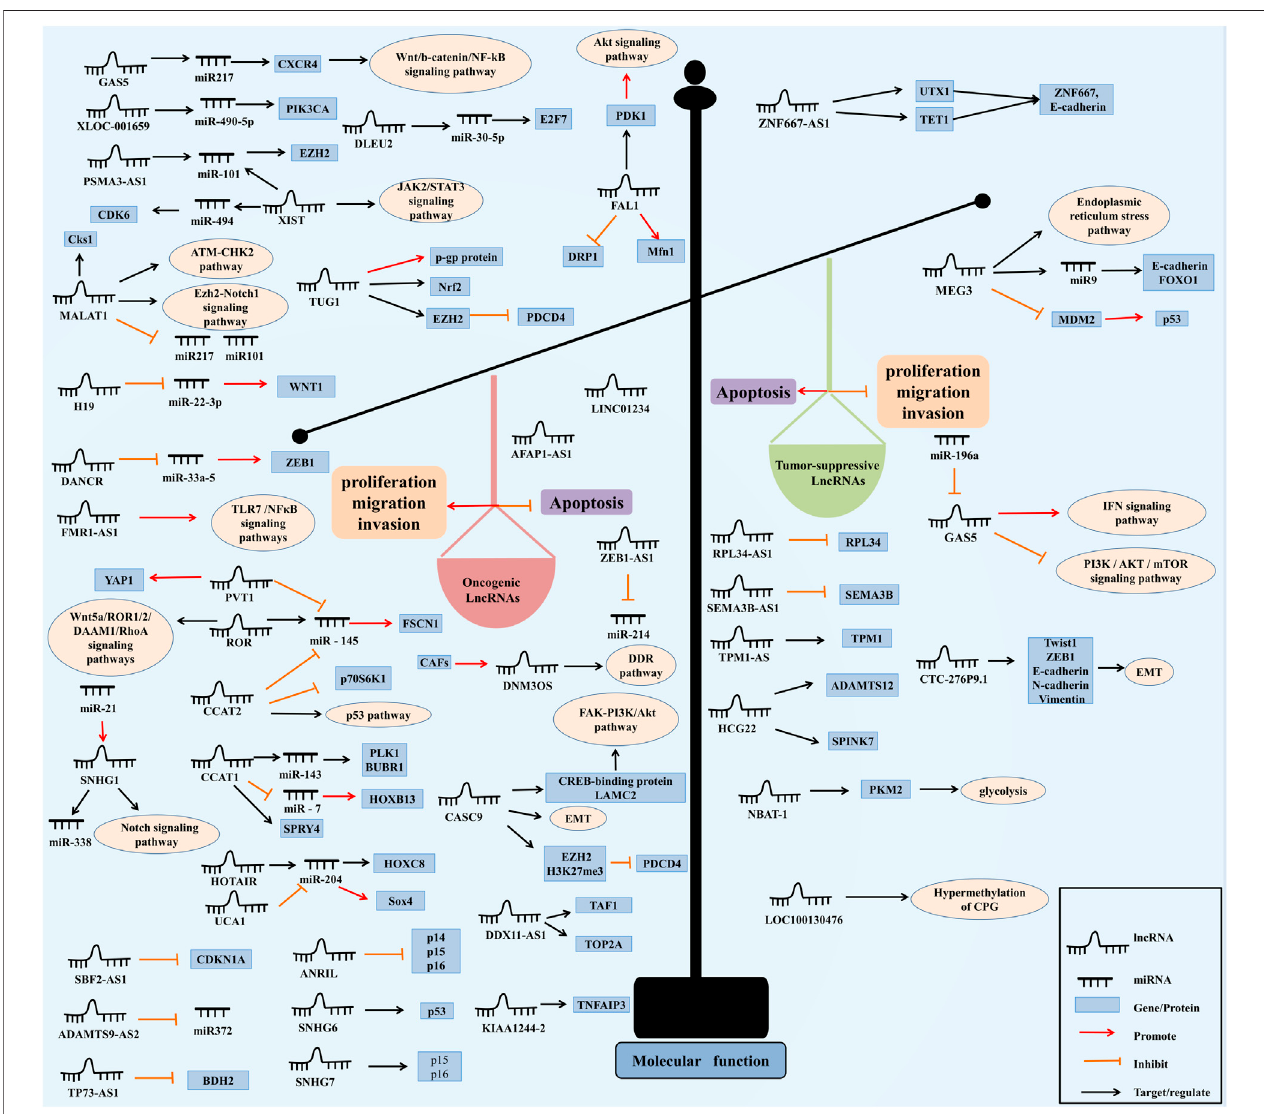
FIGURE 2 | The molecular functions of lncRNAs in EC. LncRNAs function as oncogenes or tumor suppressors. On the left, lncRNAs act as oncogenes and are overexpressed in EC. On the contrary in right, lncRNAs act as tumor suppressors and are down-regulated in EC. As reported for the functional mechanisms, lncRNAs can be divided into the cis-acting lncRNAs and trans-acting lncRNAs. Cis-acting lncRNAs can regulate the chromatin state and/or expression of nearby genes: 1) the lncRNA transcript regulates the expression of nearby genes through recruiting regulatory factors (Kopp and Mendell, 2018); 2) the transcription or